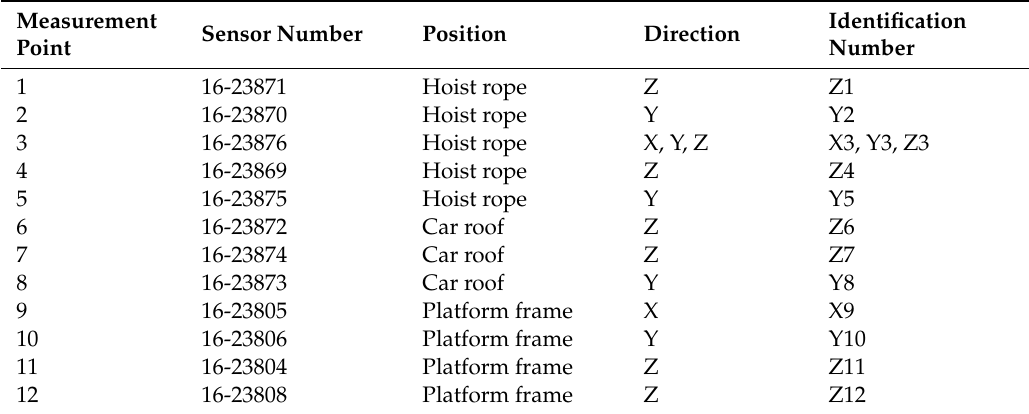
Table 1. Arrangement of measurement points.